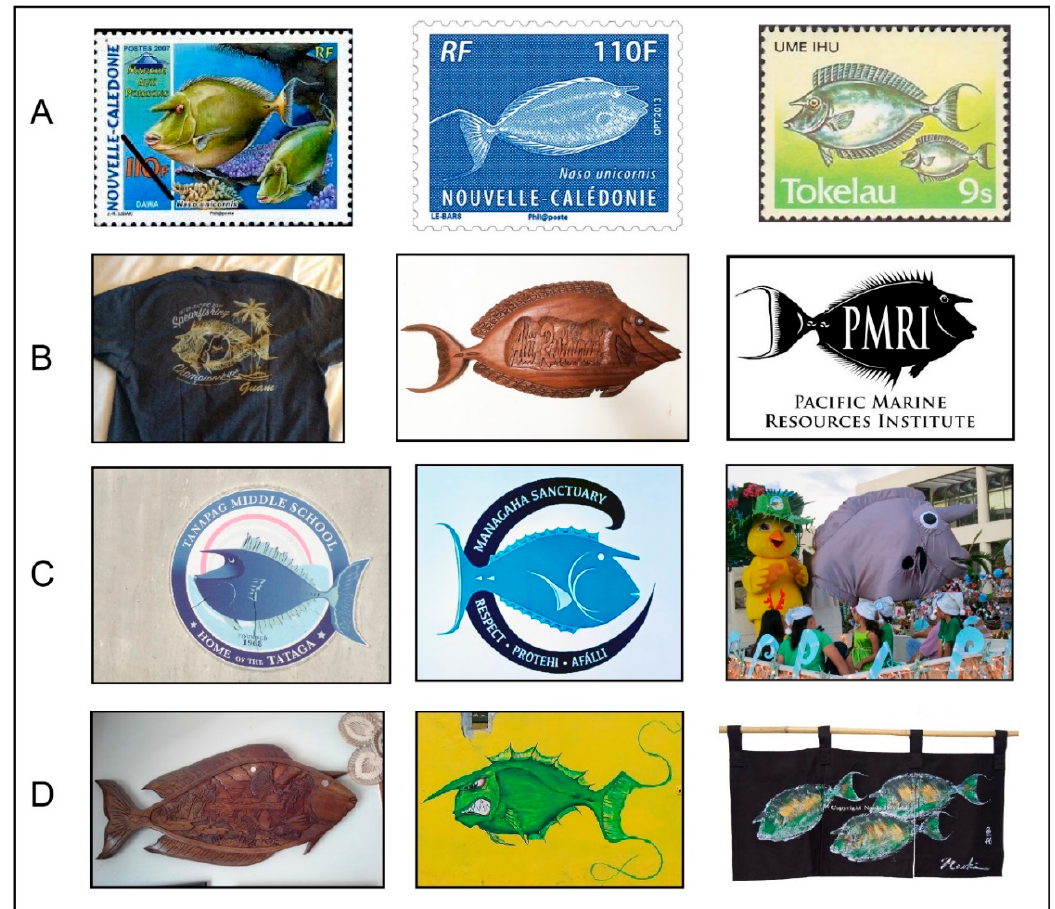
Figure 1. The likeness of the bluespine unicornfish Naso unicornis is common across the insular Pacific region, demonstrating its ubiquitous importance to Pacific cultures. Examples include: ( a ) postage stamps (examples from New Caledonia [ Left and Center ] and Tokelau, territory of New Zealand [ Right ]); ( b ) company and event logos ( Left : event t-shirt from 2017 Inter-Pacific Spearfishing Championships; Center : hanging sign for restaurant in Palau, reproduced with permission from George Roff; Right : company logo for non-profit organization from Micronesia, reproduced with permission from Peter Houk); ( c ) mascots ( Left : school mascot for Tanapag Middle School, Saipan, Commonwealth of the Northern Mariana Islands; Center : logo for marine sanctuary in Saipan; Right : mascot in Saipan parade, reproduced with permission from Jihan Younis); and commonly seen in ( d ) regional artwork ( Left : storyboard carving in Palau, reproduced with permission from Javier Cuetos-Bueno; Center : street graffiti in Saipan, reproduced with permission from Javier Cuetos-Bueno; Right : original gyotaku artwork for sale in Oahu, Hawaii, reproduced with permission from Naoki Hayashi).